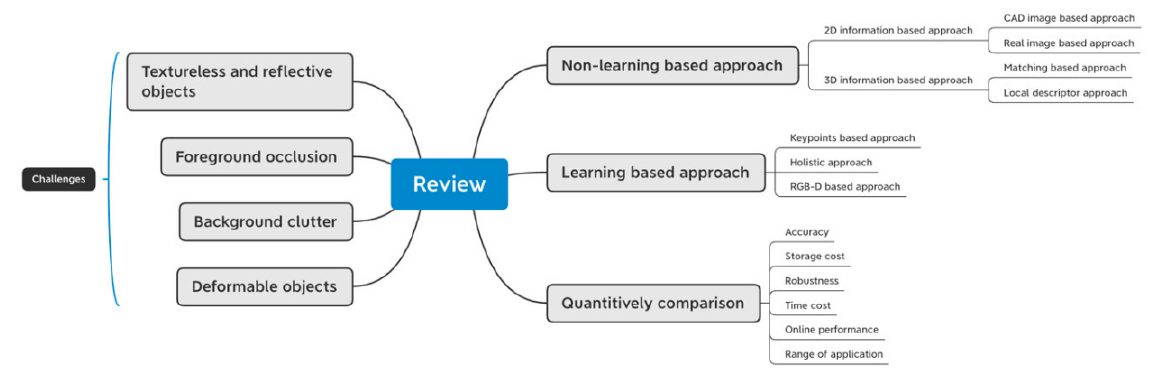
Figure 2. Structure layout of the